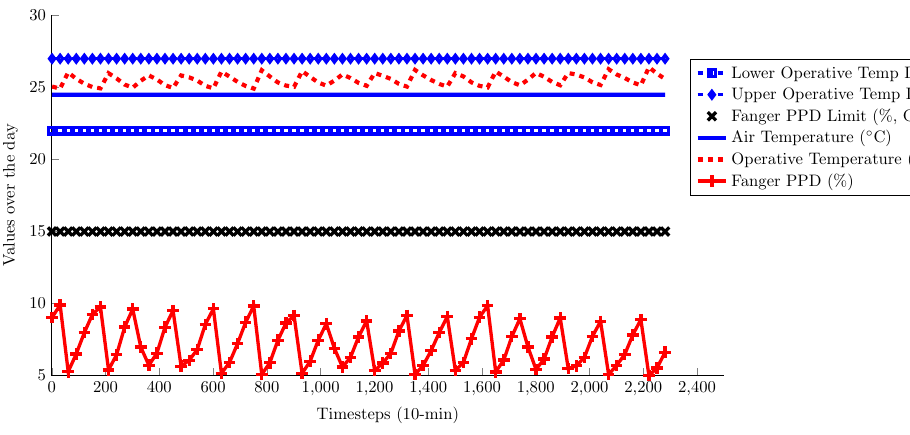
Figure 5. Summer results for Office 04 using the air temperature thermostat set at 24.5 ◦